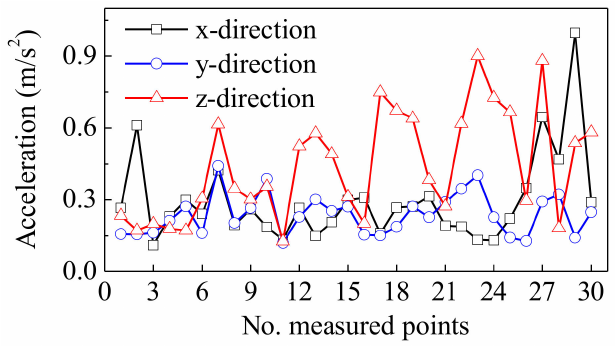
Figure 19. Acceleration distribution under rated